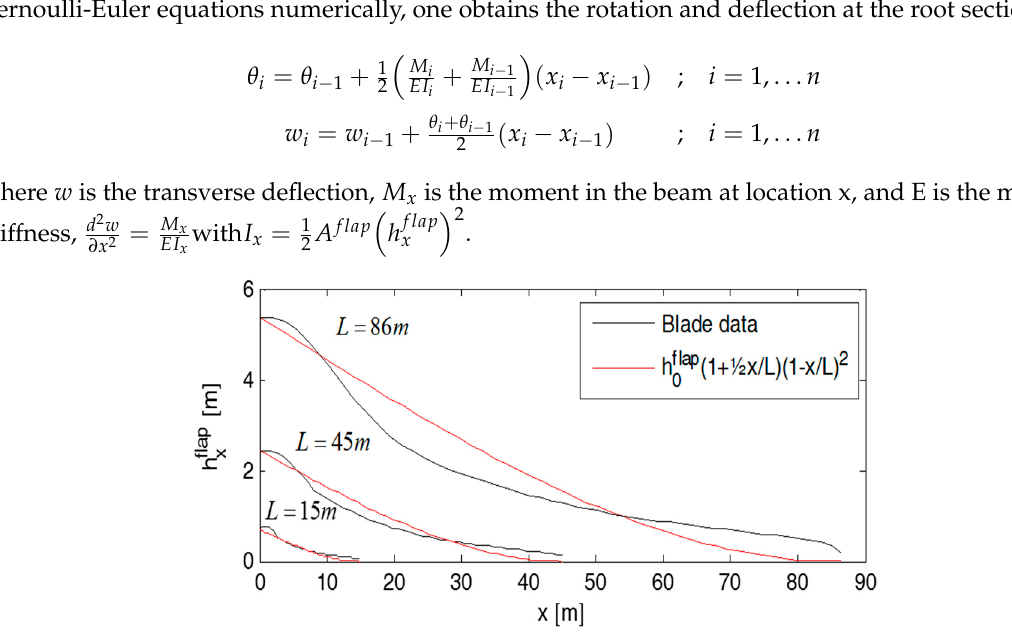
Figure 2. Typical blade geometries compared with the strength-determined geometries defined in Equation (6).